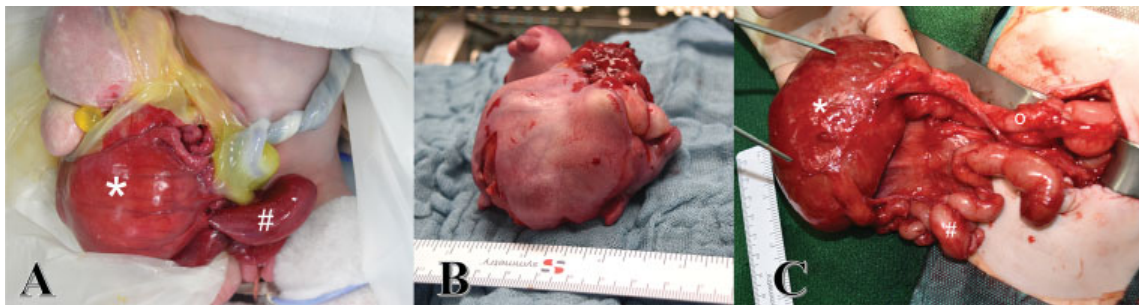
Fig. 1 ( A ) Ruptured omphalocele with umbilical cord teratoma (size of 7cm) at birth and ( B ) after resection. ( C ) Proximal duodenum (o) leading into the distal cystic duodenum ( (cid:2) ) with a caliber change of 6:1 followed by proximal stenotic jejunum (#).